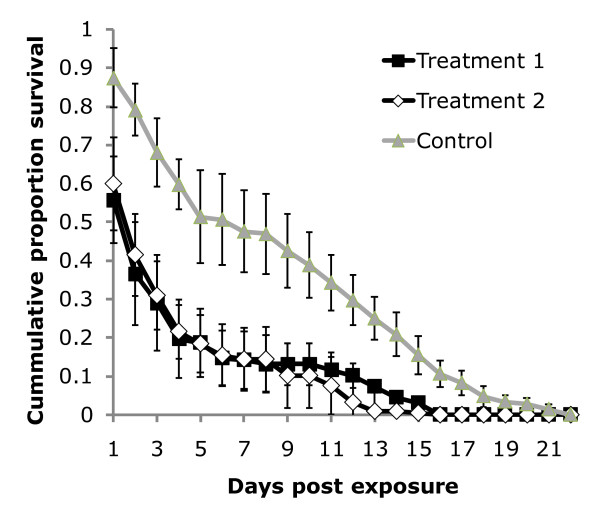
Survival of wild Anopheles arabiensis after exposure to Metarhizium anisopliae IP 46 conidia in odor-bated station.